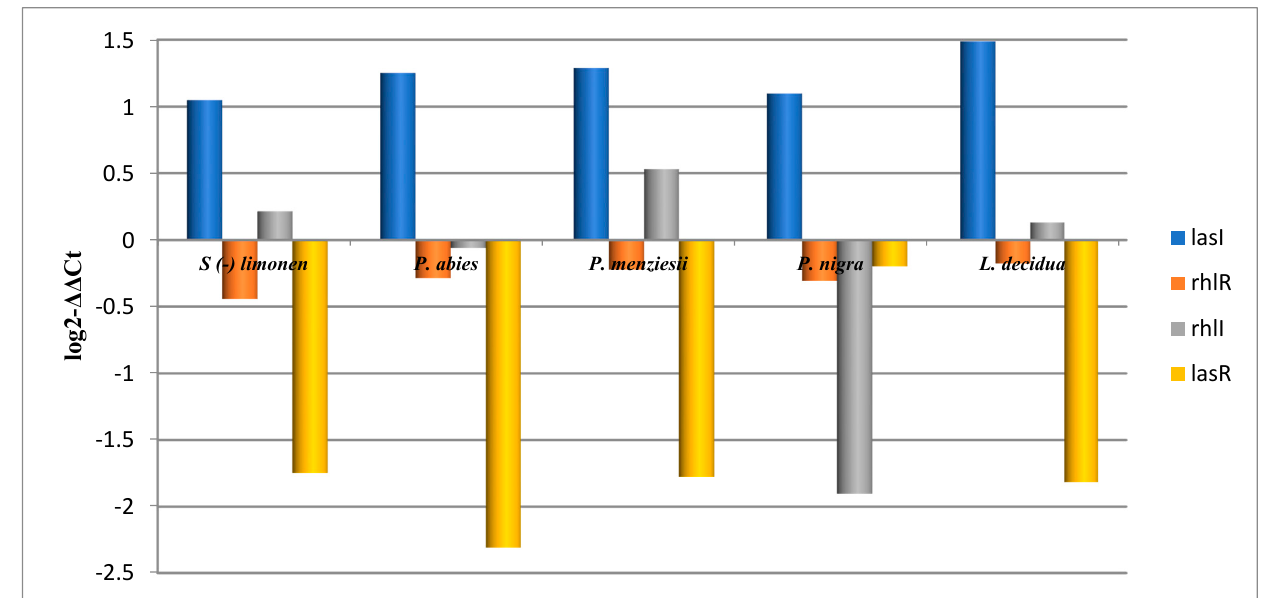
Figure 3. The QS genes expression levels in P. aeruginosa strains cultivated in the presence of limonene and EOs.